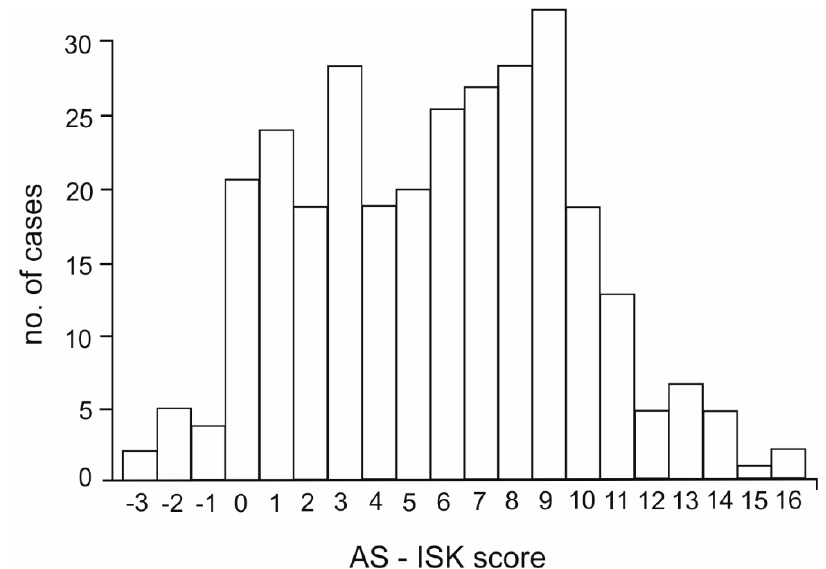
Figure 1. Distribution of AS-ISK score (from Biology/Ecology section only) of ornamental reptile species (excluding turtles) for the EU area.